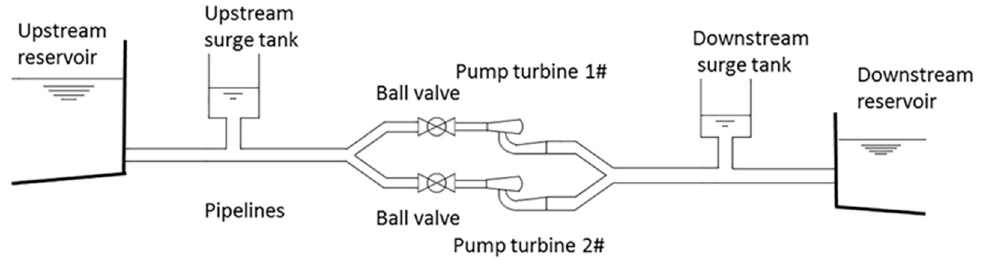
Figure 1. Basic configuration of a pumped-storage plant (PSP) with two pump turbines sharing the same main pipelines.